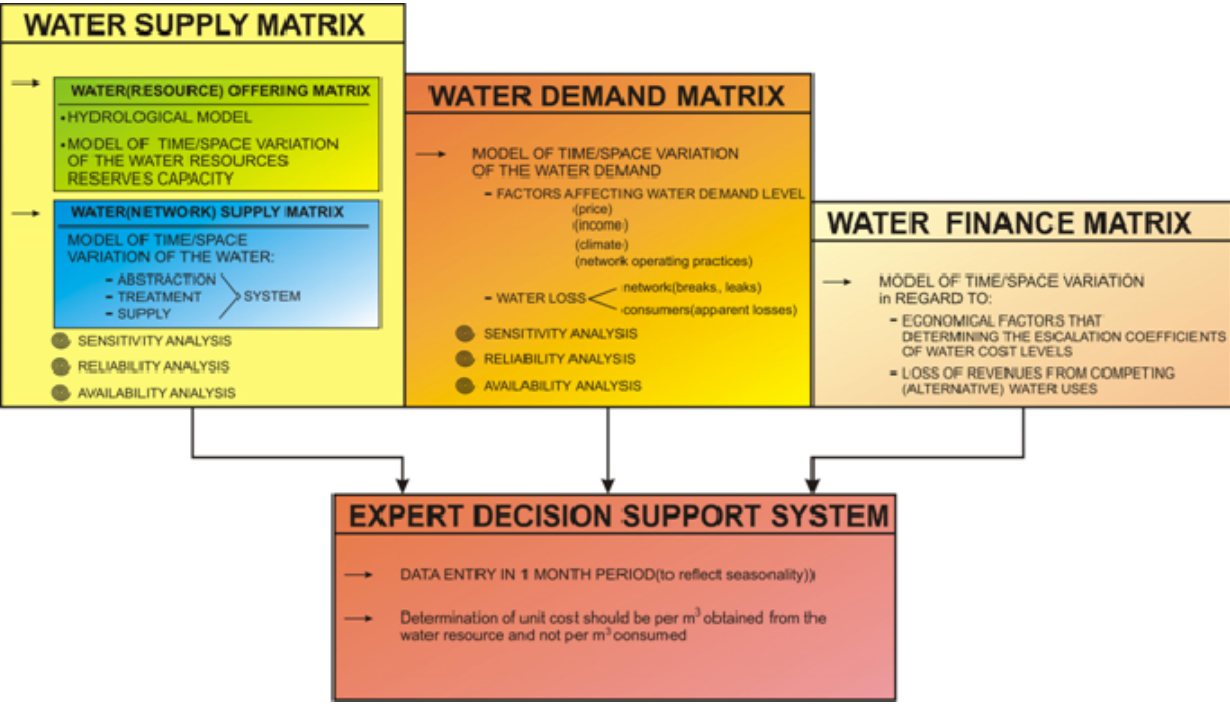
Figure 5. The suggested Expert Decision Support System (EDSS) connecting platform